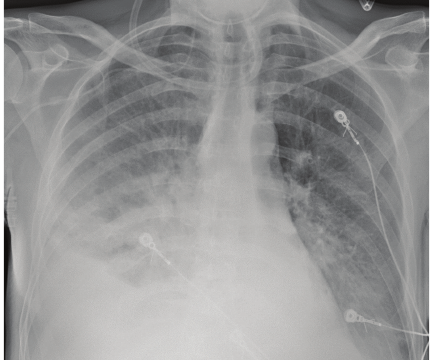
Figure 3: Chest X-ray, 2h after admission, revealing a rapidly evolving right pleural